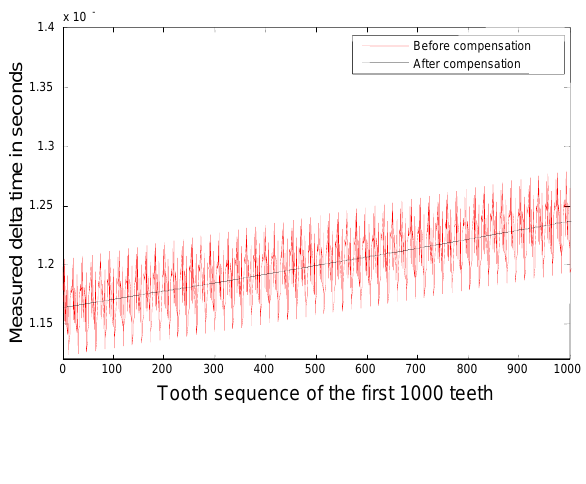
Figure 7. Measured time T  before- and after- compensation.